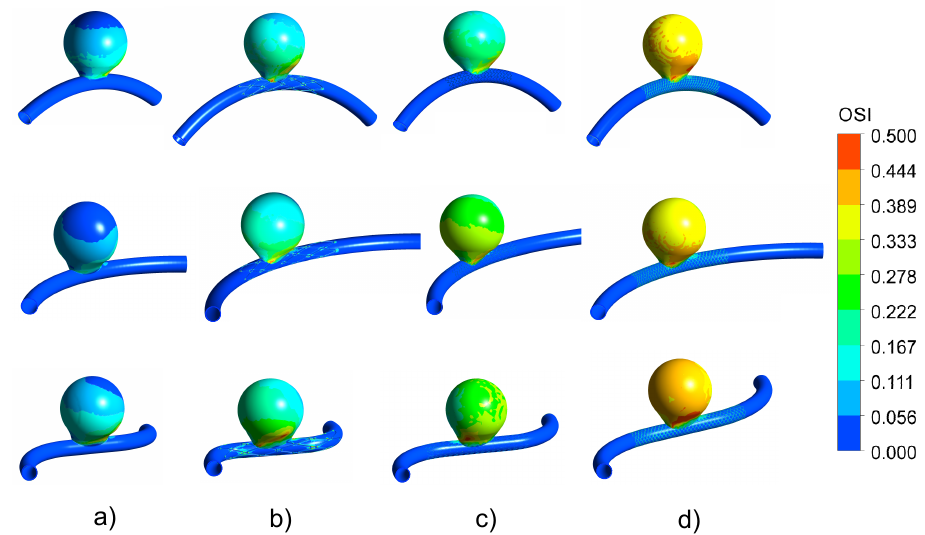
Figure 7. Spatial distribution of the shear index (OSI) for the three vessel configurations (top row, V-bent vessel; middle row, C-bent vessel; bottom row, S-bent vessel) and the three stents: ( a ) no stent, ( b ) STENT 1, ( c ) STENT 2 and ( d ) STENT 3.